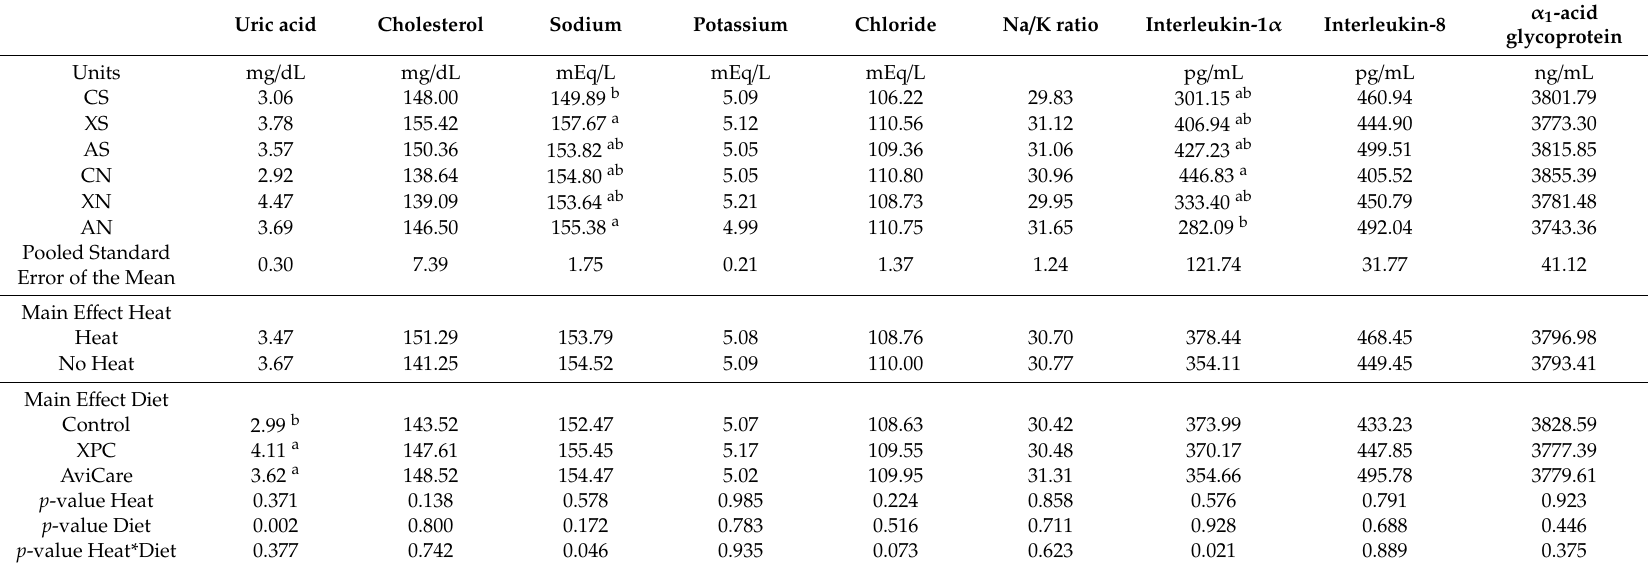
Table 4. Blood plasma chemistry and cytokine levels in straight run White Pekin ducks after 33 d of growth 1